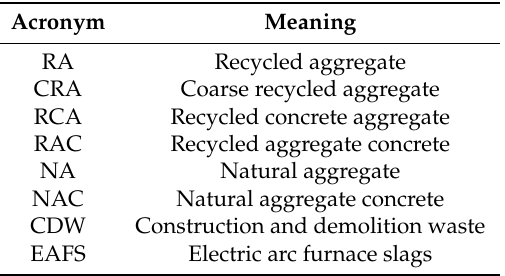
Table 1. Acronyms used in the